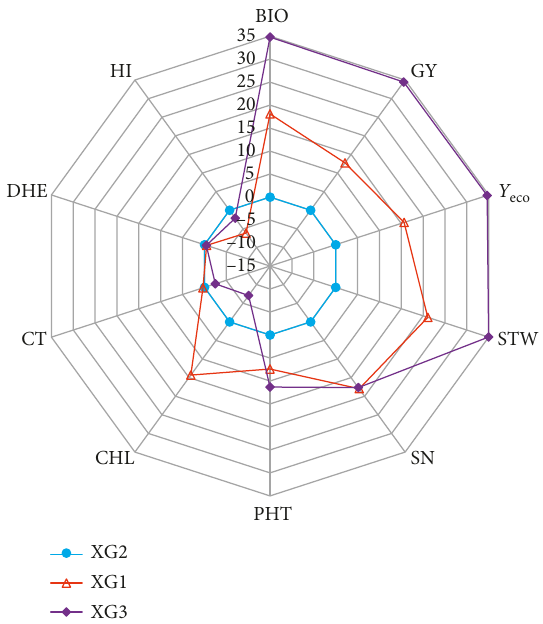
Figure 1: Relative deviation of the performances of clusters XG1 and XG3 as percent of mean values of cluster XG2 for the measured